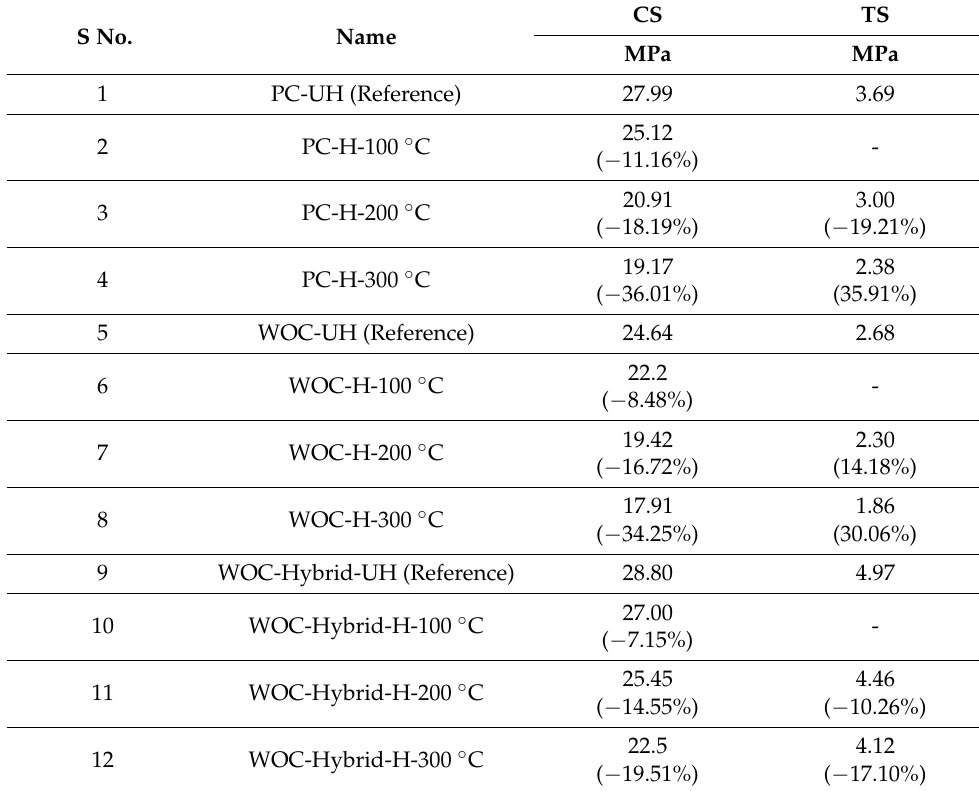
Table 7. Average compressive and tensile strength for various mixes. S